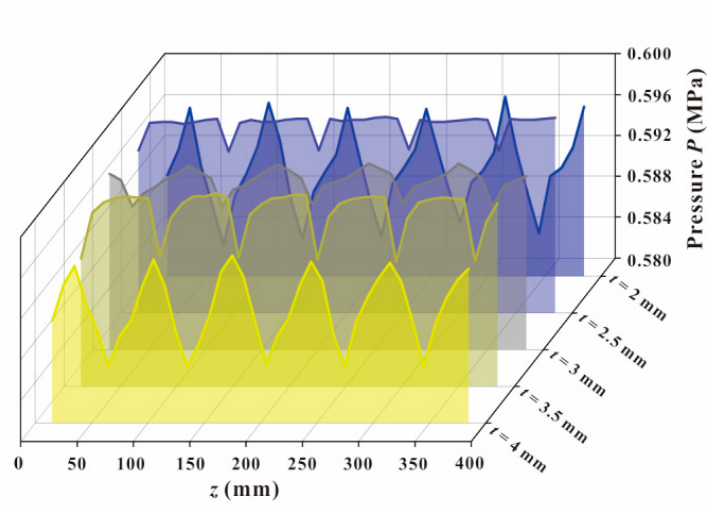
Figure 14. Pressure distribution with a fin height h = 10 mm and fin pitch p = 15 mm.